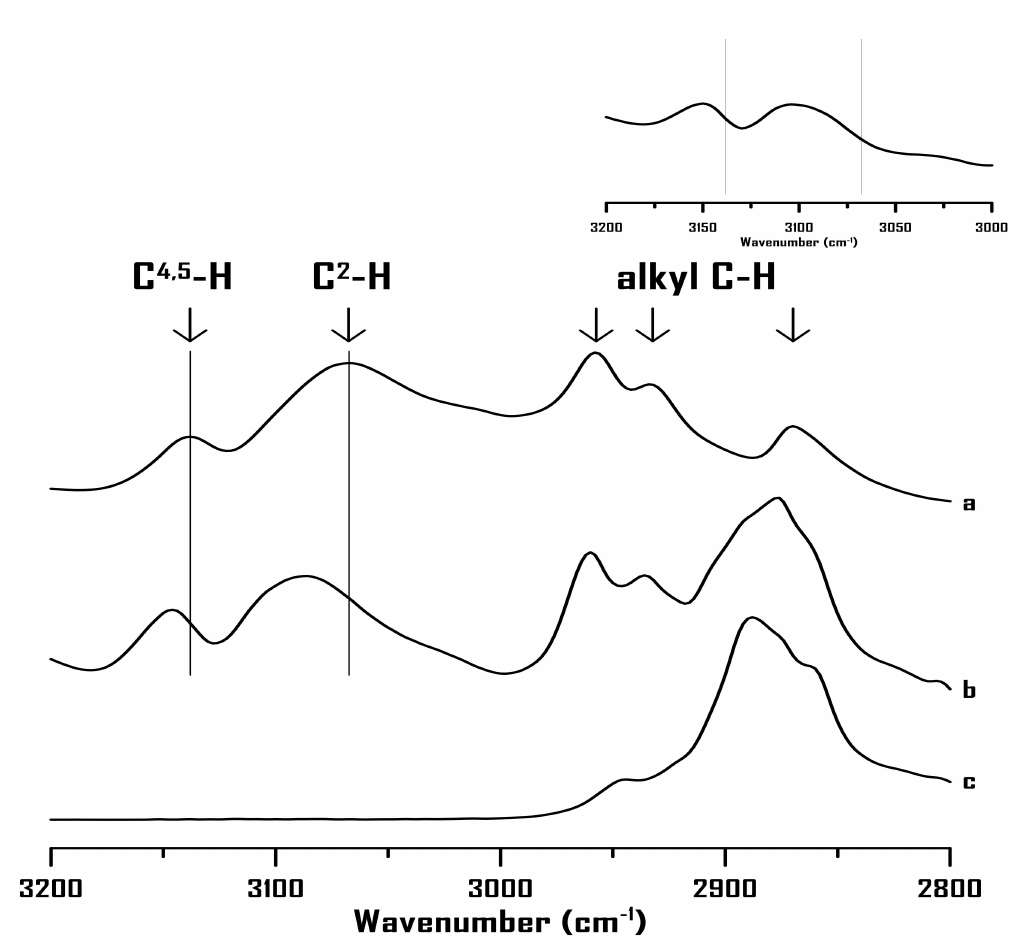
Figure 1. Infrared (IR) spectra of ( a ) pure [BMIM]Br, ( b ) mixture of PEO containing 75 wt% [BMIM]Br, and ( c ) pure PEO at ambient pressure. Upper-right corner: the difference spectrum